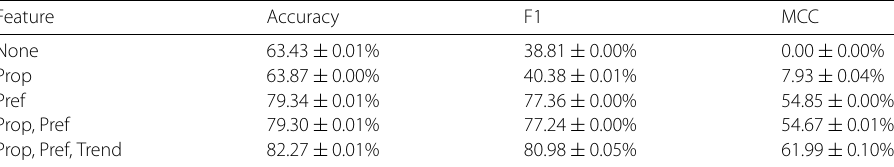
Table 7 Effect of author property and topic trend on the prediction performance (Reddit). The mean and the 99% confidence interval for 200 trials are shown